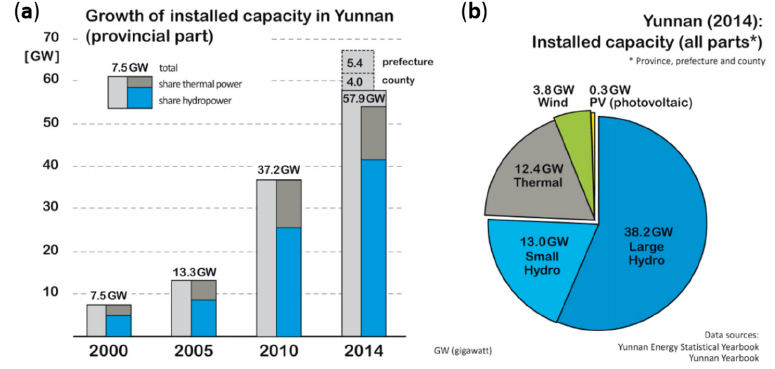
Figure 3. ( a ) Growth of Yunnan’s power sector and ( b ) its sectoral and administrative shares in 2014.